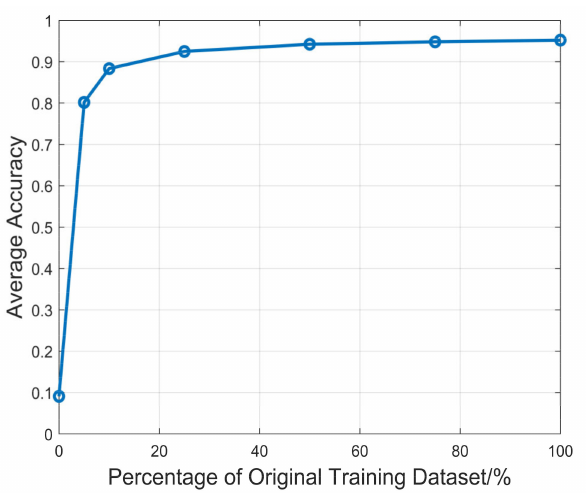
Figure 9. The average accuracy of 1-D SKCNN on testing dataset when the volume of training dataset is 0%, 5%, 10%, 25%, 50%, 75% and 100% of the original training dataset.